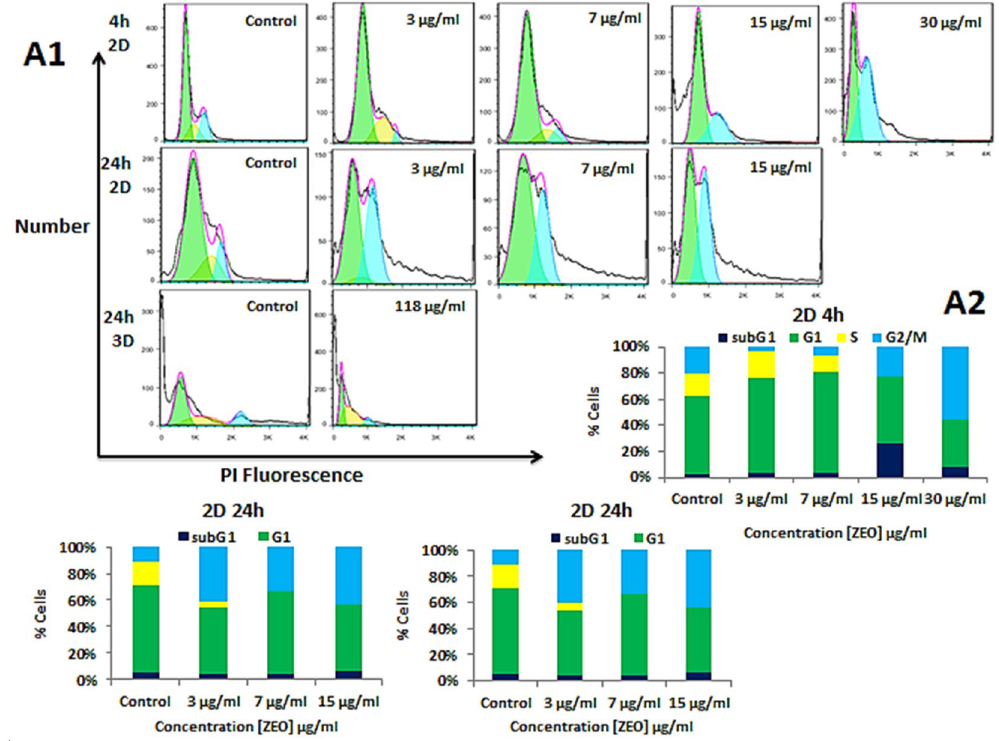
Figure 7. Effect of ZEO on DNA content in 2D and 3D cell cultures. ( A1 ) DNA profile of MDA-MB-231 cells in monolayer treated with different concentration of ZEO for 4 and 24 h, and MDA-MB-231 cell spheroids incubated with IC50 concentration of ZEO for 24 h using flow cytometry. ( A2 ) Percentage of cells population in sub-G1, G1, S and G2/M phases in 2D and 3D cell cultures analyzed with flowJo